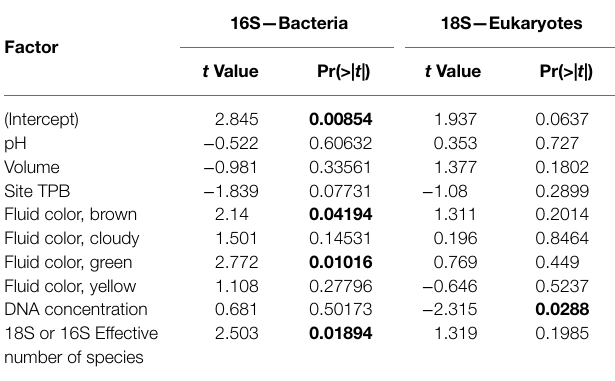
TABLE 1 | Factors affecting bacterial and eukaryotic community richness [generalized linear model (GLM) results].